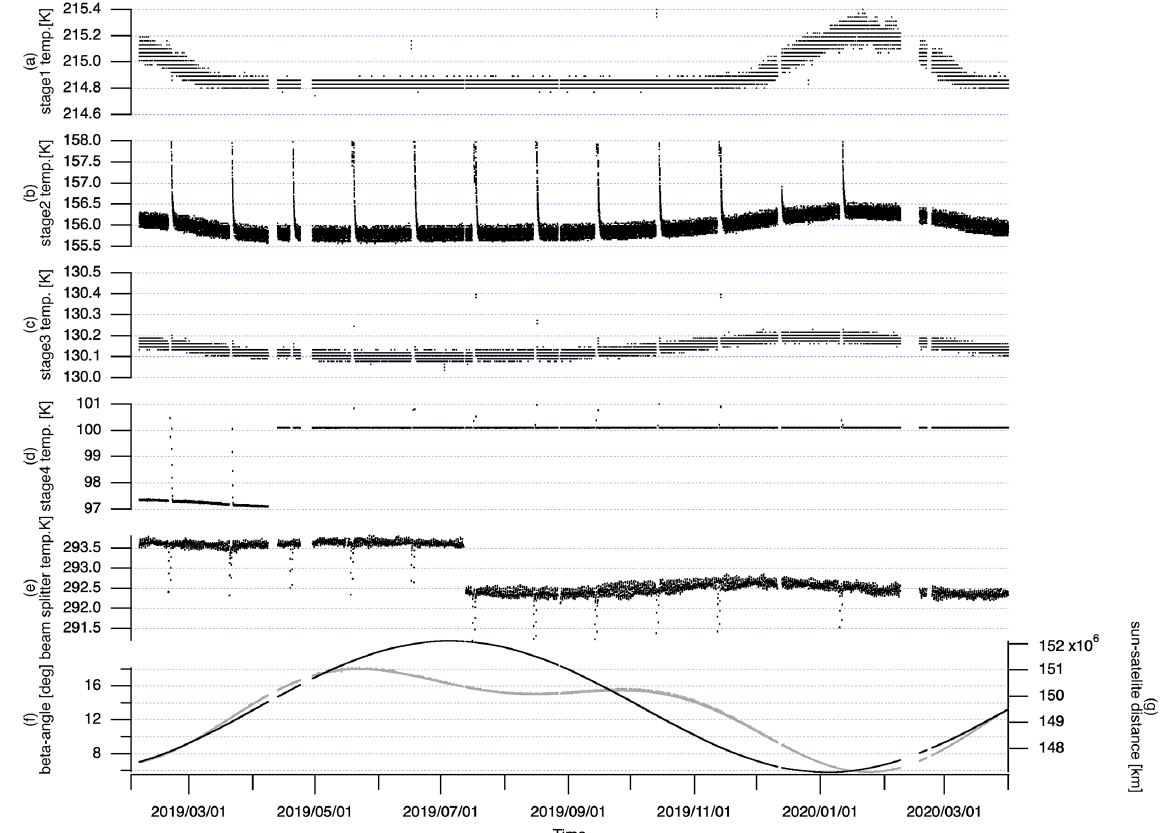
Figure 9. Time series of temperatures: (a) cooler stage1, (b) cooler stage2, (c) cooler stage3, (d) cooler stage4, (e) beam splitter on interfer- ometer, (f) satellite beta angle (grey with left axis), and (g) sun–satellite distance (black with right axis).